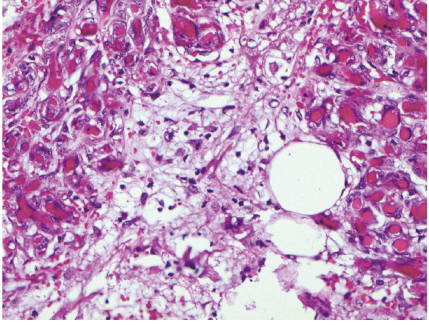
Figure 5: Gross image with hemorrhagic, infarcted omentum adhered to the anterior abdominal wall.